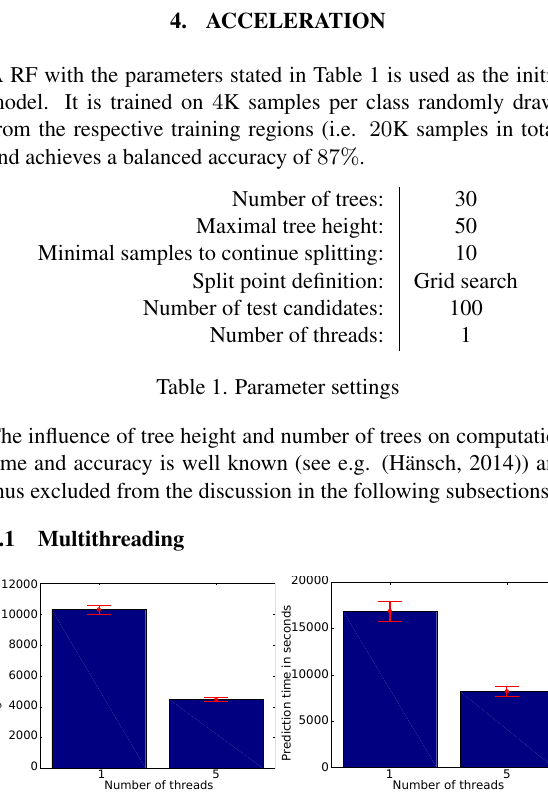
Figure 2. Change in training and prediction time by using different number of